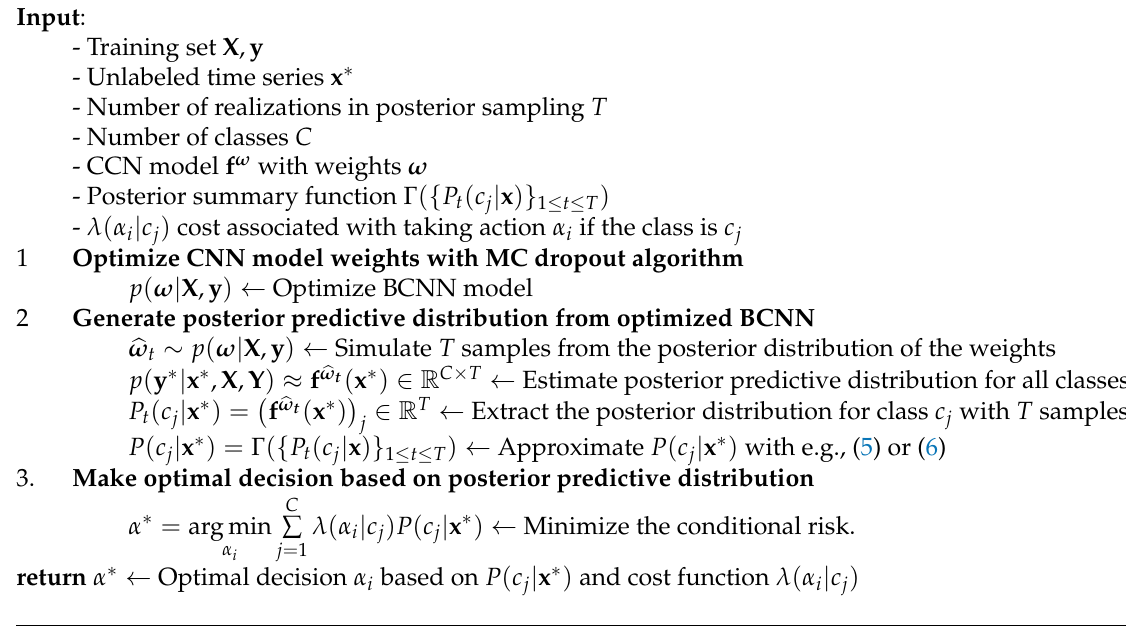
Algorithm 1 Algorithm for decision support in environmental monitoring under